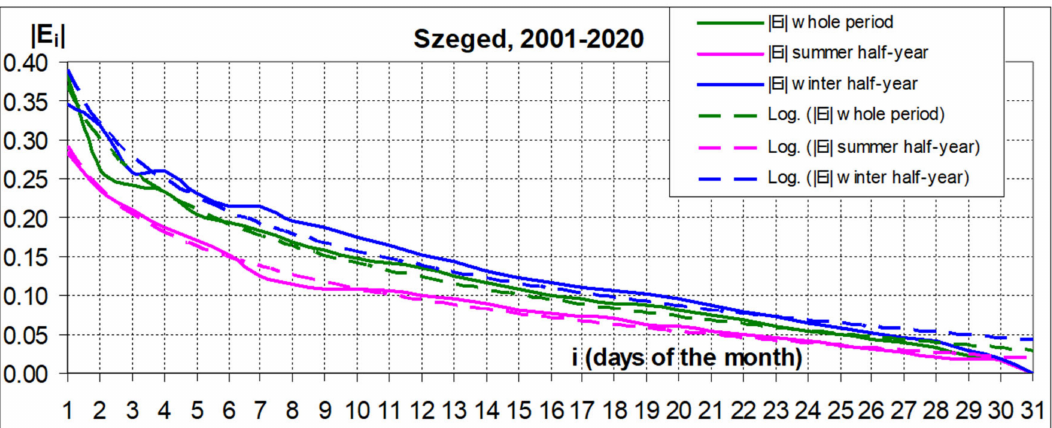
Figure 8. Monthly runs of average absolute deviations (100| E i |: as a